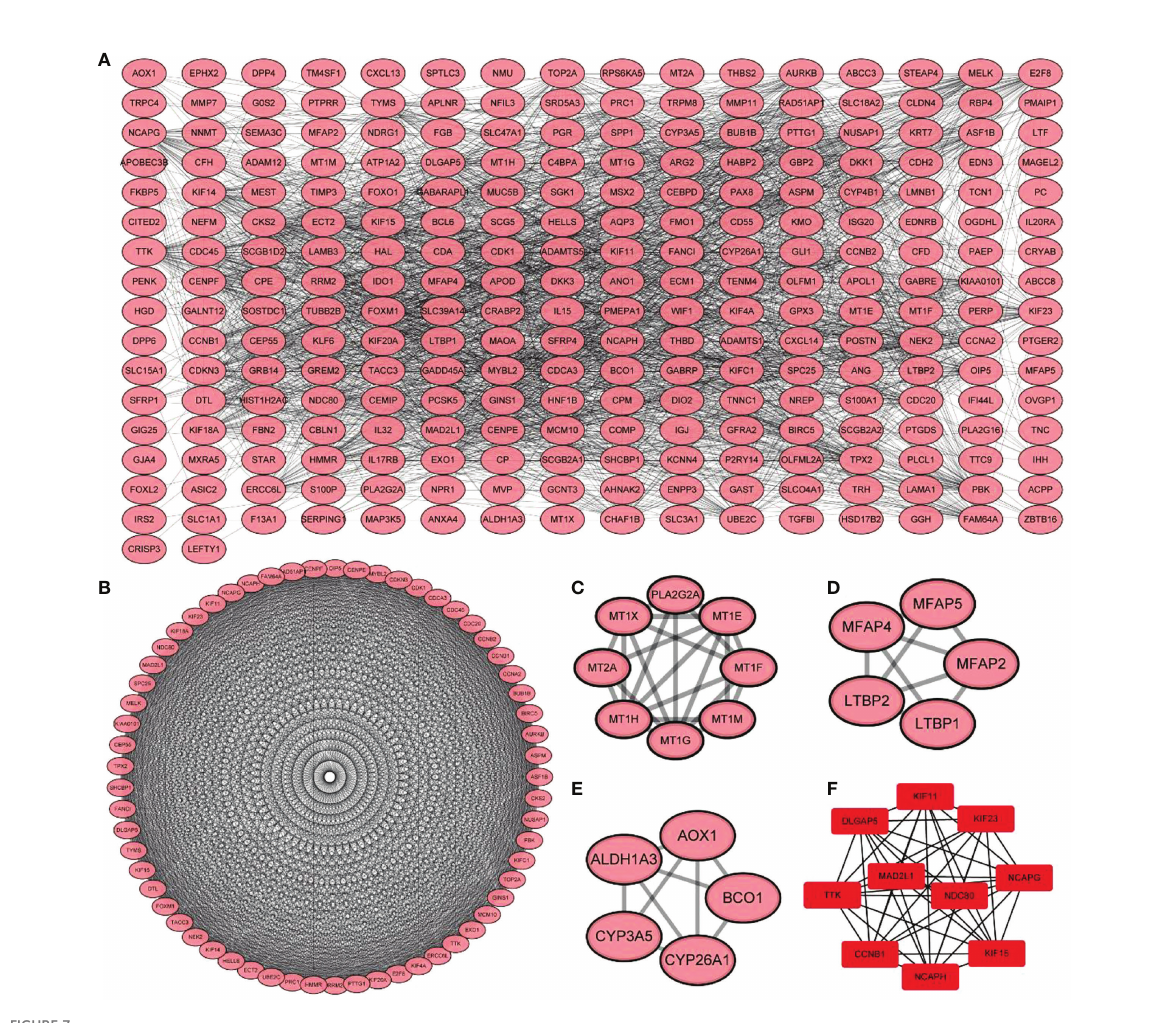
FIGURE 7 Protein-protein interaction network construction and core molecular screening of differentially expressed immune genes. (A) protein-protein interaction network of differentially expressed immune genes; (B – E) MCODE plug-in screening subnetwork; (F) Cytohubba plug-in screening core